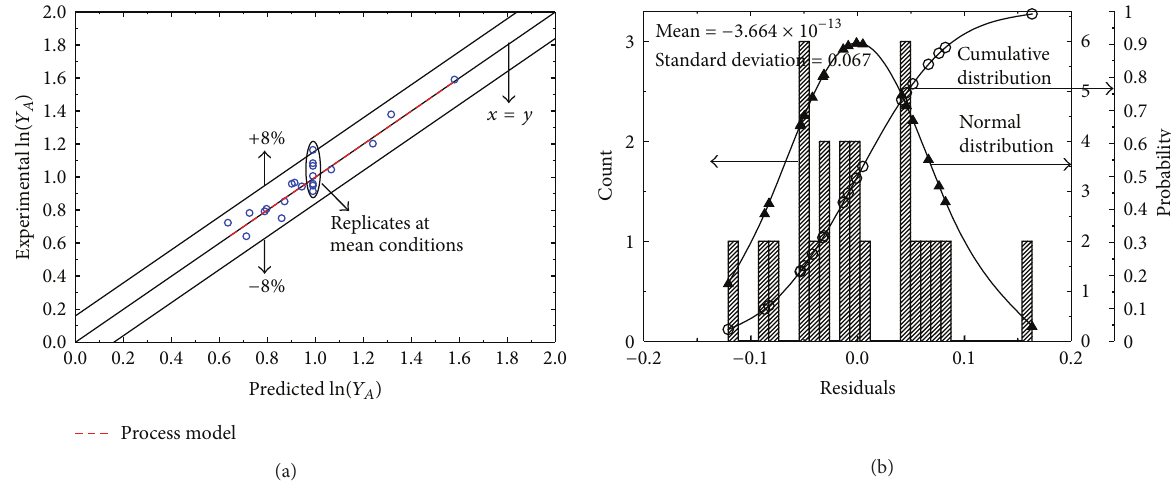
Figure 3: (a) Multivariate model relating the sludge yield 𝑌 𝐴 during liquid-liquid extraction with alcohol to process variables 𝑡 , 𝑇 , and 𝑟 . (b) Corresponding residual